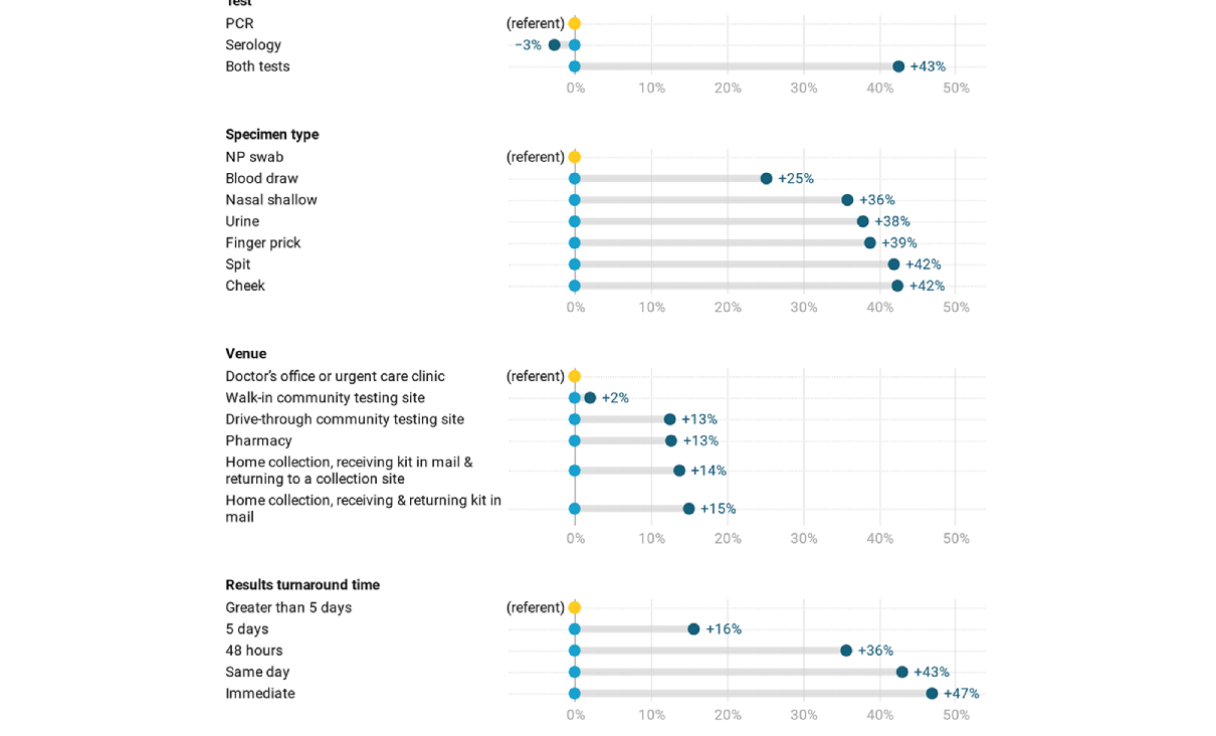
Figure 1. Simulated changes in SARS-CoV-2 testing uptake relative to the current typical testing option, by attribute level. The current typical testing option is PCR via NP swab in a provider’s office or urgent care clinic with results in >5 days. The baseline simulation included the current typical testing option compared to a second duplicate current typical testing scenario and a no test scenario. Changes in uptake in subsequent simulations were estimated by individually varying each attribute level in the duplicated scenario, holding other attributes constant. The referent value of zero is the difference between the original and duplicated typical testing scenarios at baseline. NP: nasopharyngeal; PCR: polymerase chain